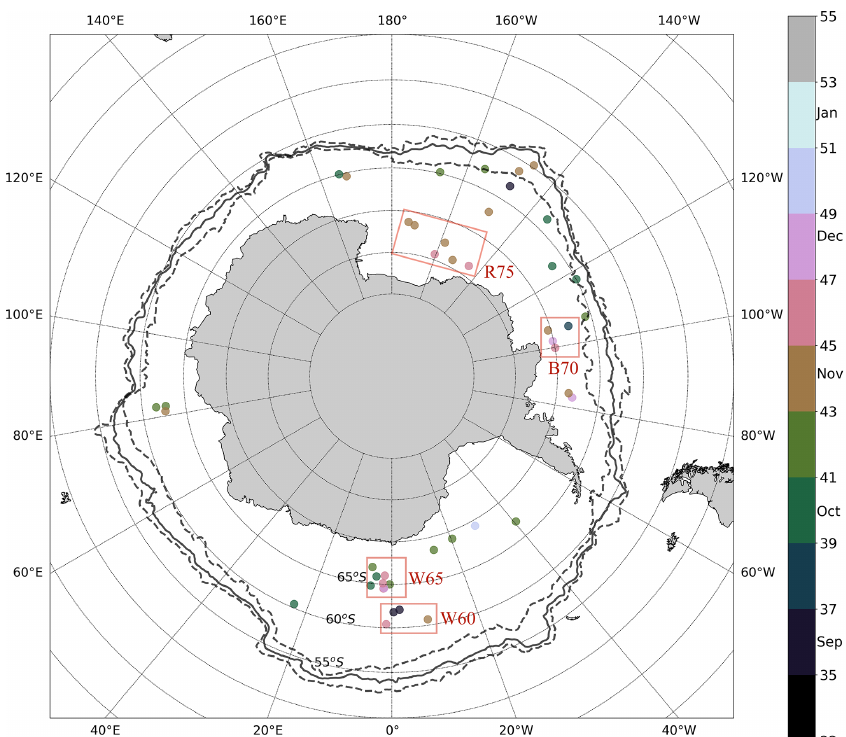
Figure 3. Approximate locations of melt events identified in the under-ice Biogeochemical Argo (BGC-Argo) data set. The solid black line represents the mean maximum extent of the 15% sea ice concentration contour for the period 2015–2018, while dashed lines represent the interannual variability. The colour of each point represents the timing of the growth initiation (GI) in weeks of the year. Red boxes refer to study regions discussed in the